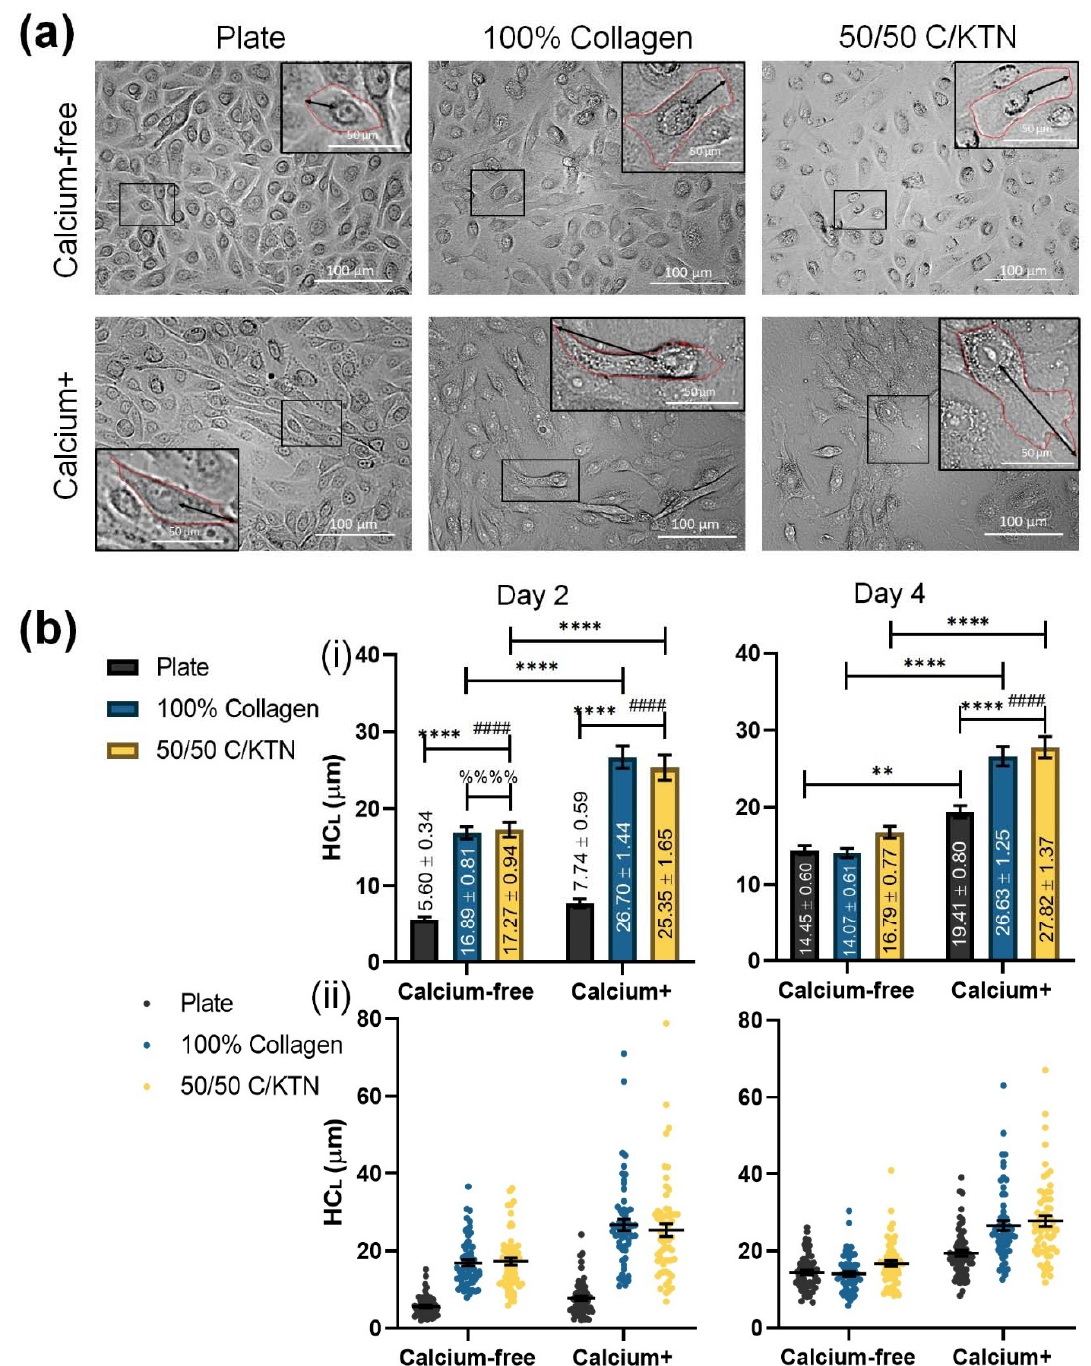
Figure 4. Half-cell length (HC L ) of keratinocytes under the influence of calcium and hydrogel composition. Day 2 and day 4 keratinocytes seeded on either a plate or a hydrogel were imaged in BF to visualize and measure the half-cell length ( a ). HC L was measured and plotted to compare different groups and media, with significant increases observed for 100% collagen and 50/50 C/KTN when compared to keratinocytes seeded on a plate; displayed as average ± SEM ( b ( i )). Each measurement of HC L is also plotted to show the distribution ( ii ). Two-way ANOVA was performed and the different symbols (*, #, %) correspond to the comparisons and the number of symbols correspond to the p-value for each comparison: with * = p < 0.05, ** = p < 0.01, *** = p < 0.001, **** = p < 0.0001; * = 2D plate vs. 100% collagen, # = 2D plate vs. 50/50 C/KTN, % = 100% collagen vs. 50/50 C/KTN; n = 60.